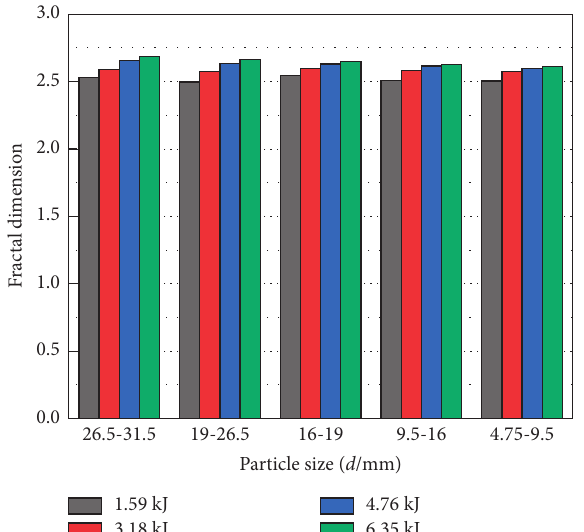
Figure 12: Comparison of parting dimensions of recycled bricks under different impact